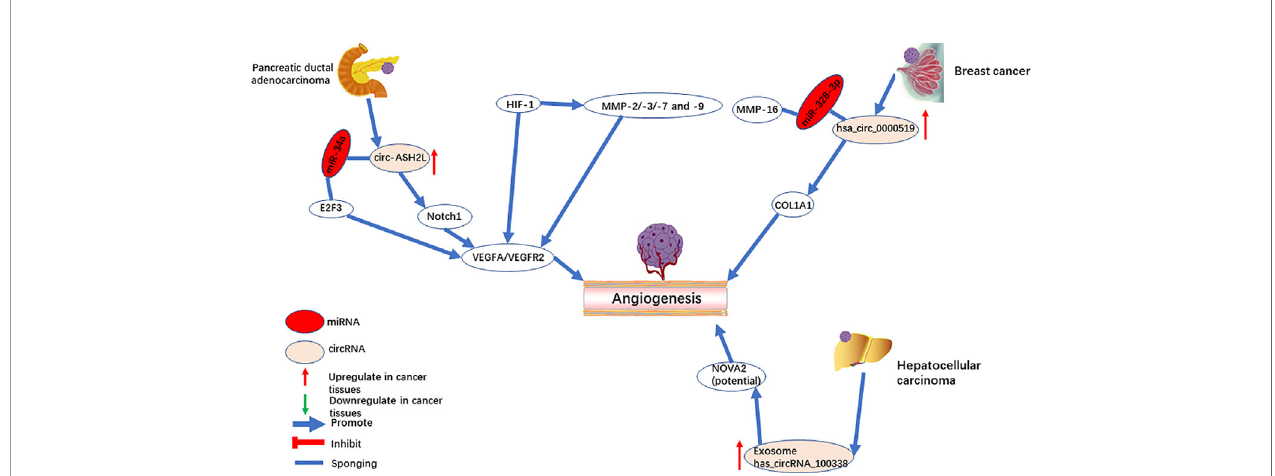
FIGURE 2 | CircRNAs mediate angiogenesis in pancreatic ductal adenocarcinoma, breast cancer, and hepatocellular carcinoma.